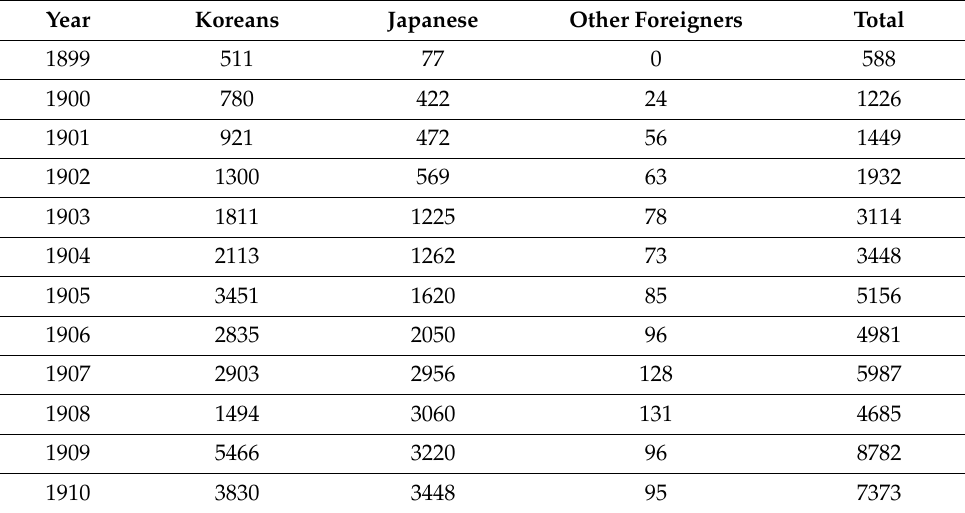
Table 2. Increase in Gunsan’s population after port opening